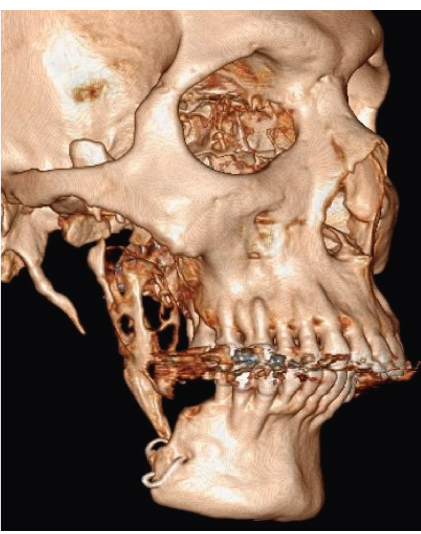
Figure 1: 3-Dimensional reconstruction of CT imaging shows re- current tumour of the grafted bone and remnant coronoid process.